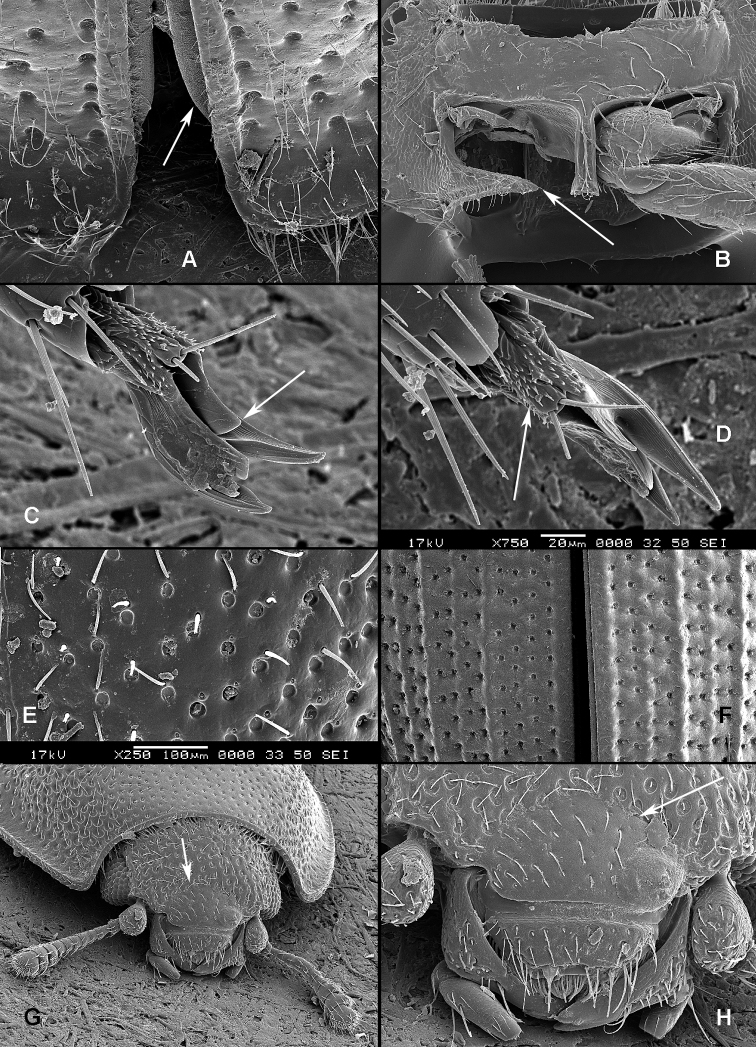
A
Thymalus limbatus, elytral apex with interlocking mechanism B–E
Decamerus haemorhoidalis (B prothorax with partially closed procoxal cavities C metatarsal claws with denticle D protarsus with projecting empodium E irregular punctation of elytra) F
Grynocharis oblonga, elytral sculpture G–H
Lophocateres pusillus (G head in frontal view with deeply emarginate frontoclypeal suture H detail).